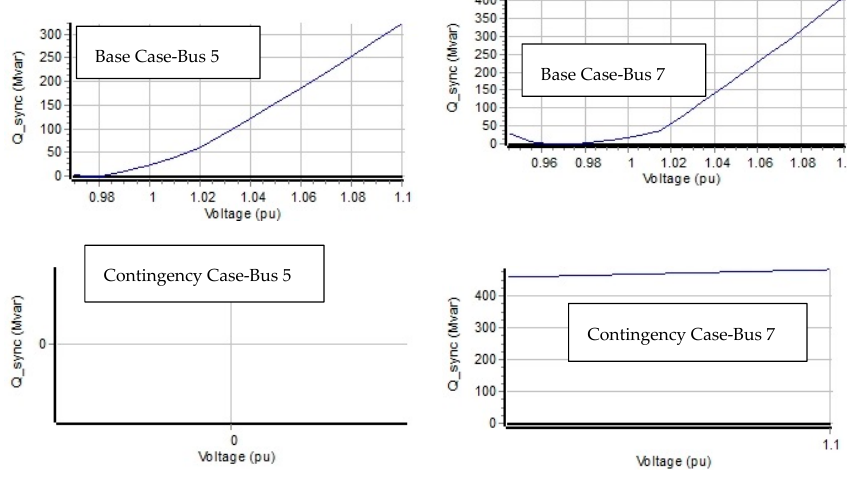
Figure 19. Q-V (Reactive Power Voltage) curves of buses 5 and 7.